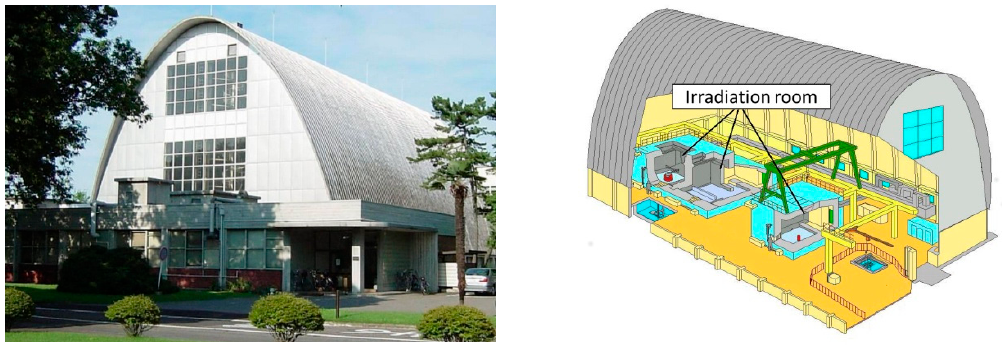
Figure 6. The external ( left ) and internal ( right ) views of one of the three buildings of the gamma-ray irradiation facilities.